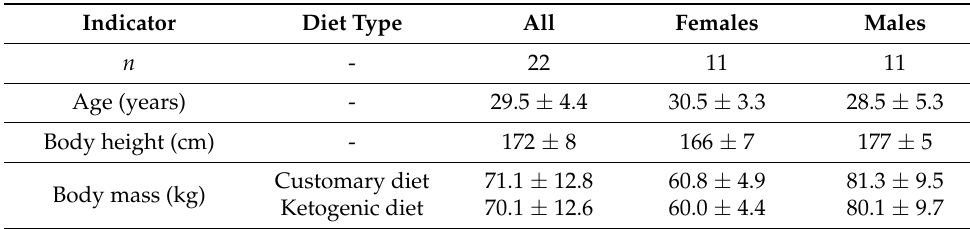
Figure 1. A flow chart of the study design. Table 1. Anthropometric characteristics.